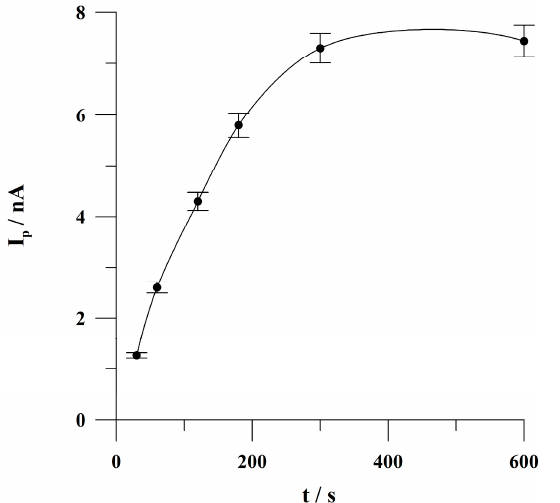
Figure 6. Effect of accumulation time on U(VI) peak current. U(VI) concentration: 2 × 10 − 8 mol L − 1 . Potential of accumulation: − 0.7 V. The error bars refer to the standard deviation (n = 3).